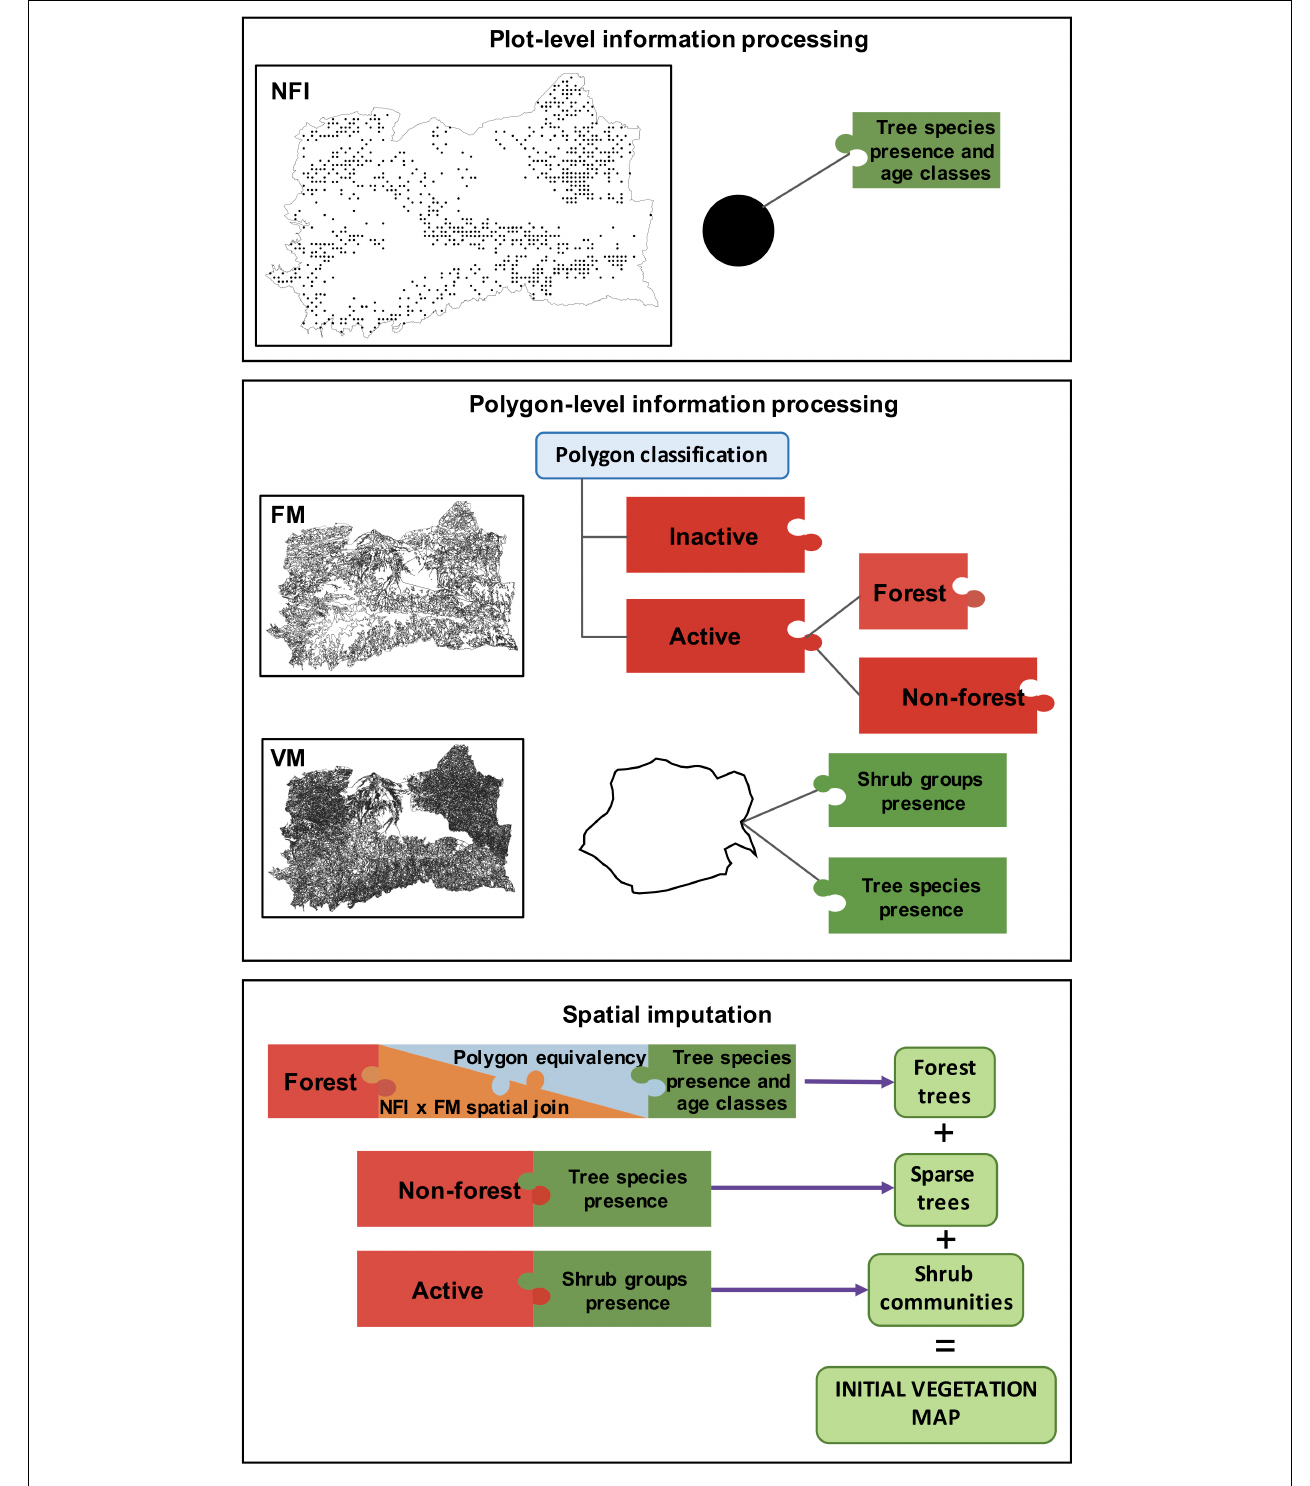
FIGURE 2 | Schematic view describing the workflow of the initial vegetation map generation. Tree species presence and age were extracted from plots of the Third Spanish National Forest Inventory (NFI) during the plot-level information processing phase. During the polygon-level information processing, the Spanish Forestry Map (FM) was used to classify polygons as active/inactive and no forest/forest. The Andalusian Vegetation Map (VM) was used to extract the presence of shrub communities and sparse trees. At the spatial imputation phase, plot- and polygon-level information was combined to generate a continuous map of vegetation.